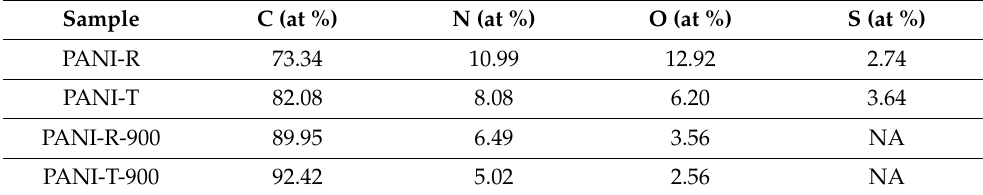
Table 1. Elemental composition of the materials from